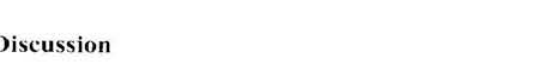
Figure 3. Micronucleus ( M N) frequency induced by 5 Gy γ-rays at different times after treatment with vari- ous concentrations of sepiapterin (SP) in RAW264.7 cells. RAW264.7 cells were incubated with sepiapterin for 0 to 24 h before irradiation with γ-rays at a dose of 5 Gy. After exposure to γ-rays, the cells were kept for 24 h under growth conditions before the quantification of micronuclei. Each point indicates the mean ± SE (n=500). The relative MN frequency was calculated with respect to the MN frequency of the group irradi- ated with 5 Gy γ-rays alone, taken as 100% at each time. *. ** and ***. significantly different from the radiation-alone group at p<0.05, p<0.01 and p<0.005,